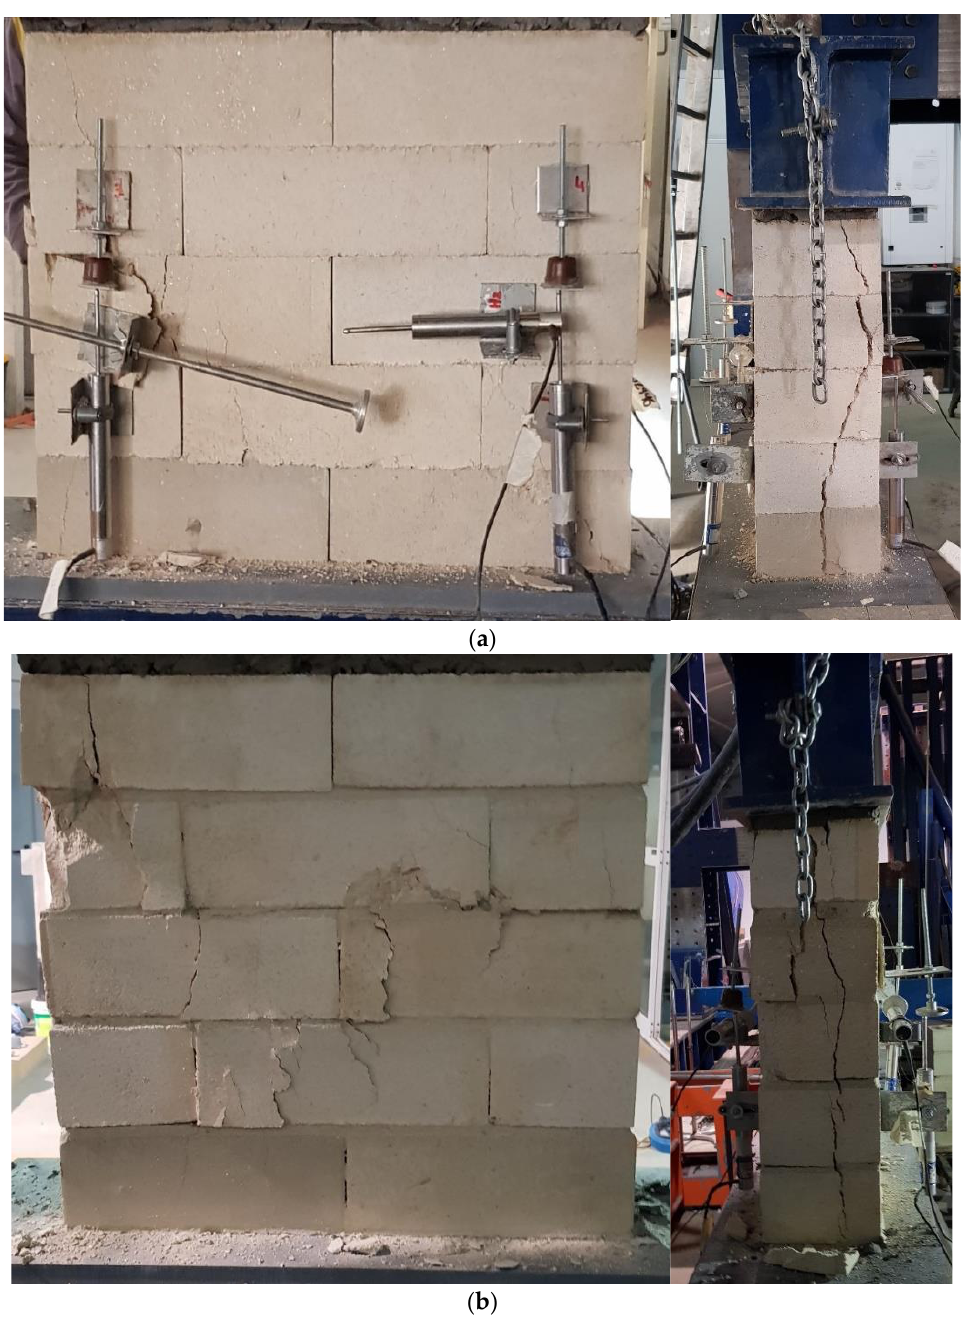
Figure 11. Failure mode of the wallettes: ( a ) DSW and ( b ) MW.